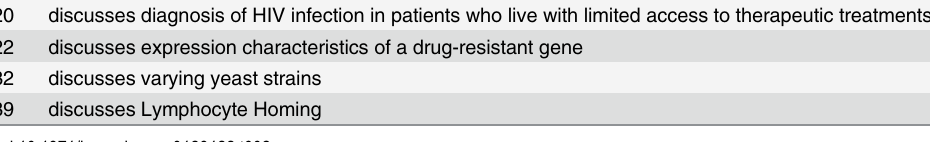
Table 2. Descriptions of Abstracts 20, 22, 32 and 39 in Fig